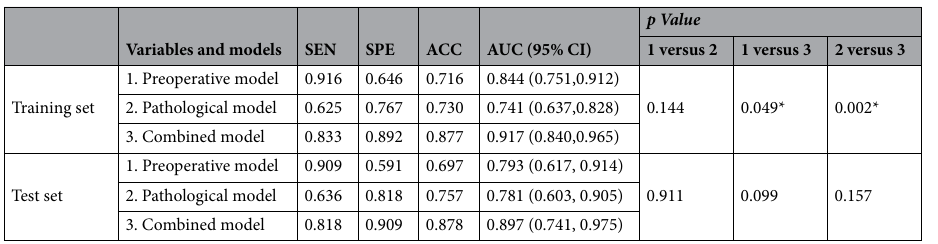
Table 5. Predictive performance of the radiomics signature and the two prediction models for the discrimination of early recurrence in training set and test set. AUC area under the curve, CI confidence interval. * p <